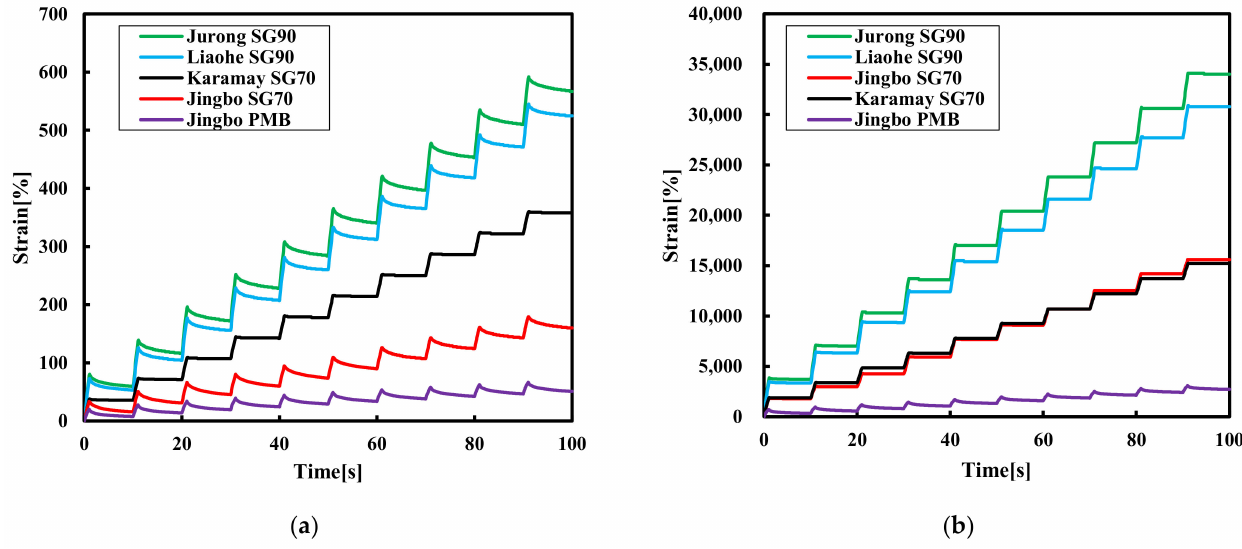
Figure 6. The MSCR results of the five bitumen binders at ( a ) 0.1 kPa and ( b ) 3.2